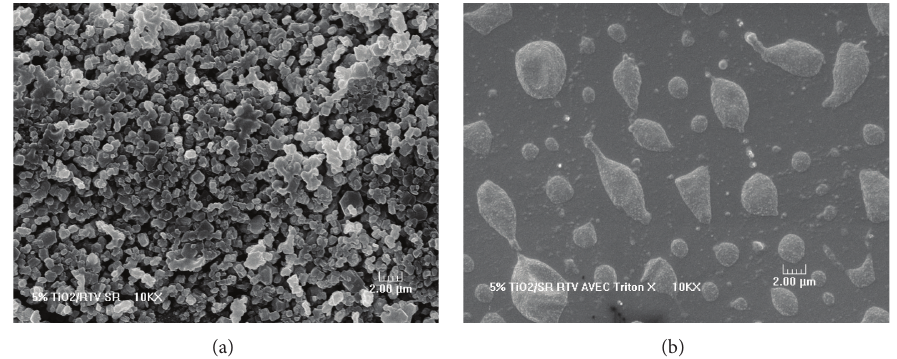
Figure 7: Effect of Triton X on the nanoparticles dispersion for RTV silicone rubber/TiO 2 (5wt%): (a) with surfactant; (b) without surfactant.